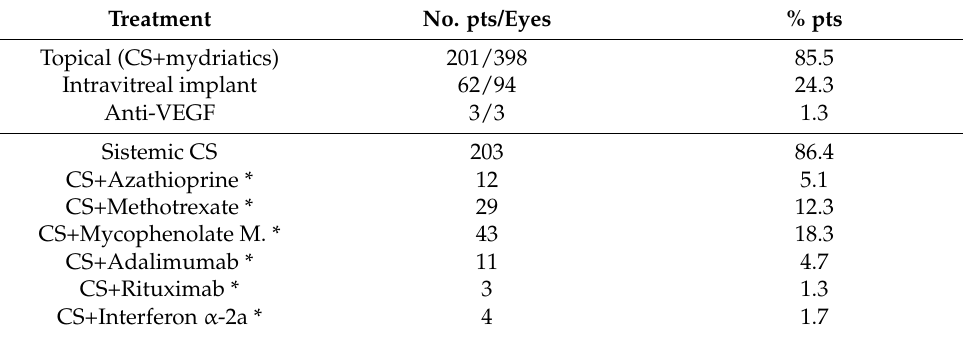
Table 7. Local and systemic treatment modalities in our